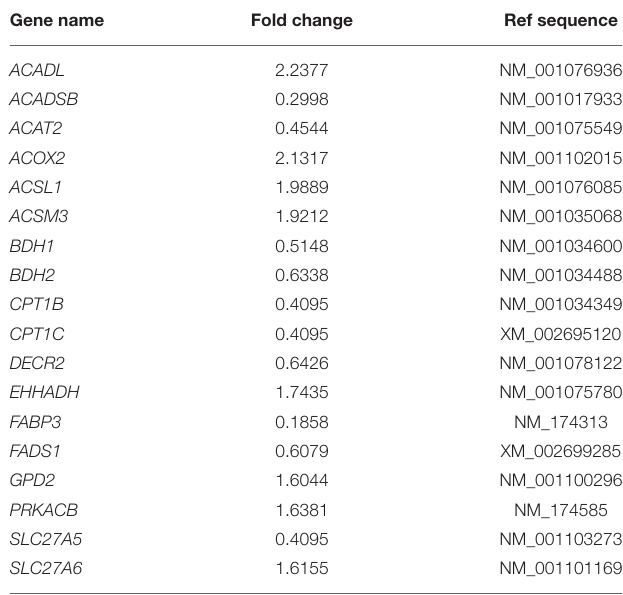
TABLE 2 | Fold changes in expression of genes involved in lipid and fatty acid metabolism that are regulated in ACADSB − / − bMECs